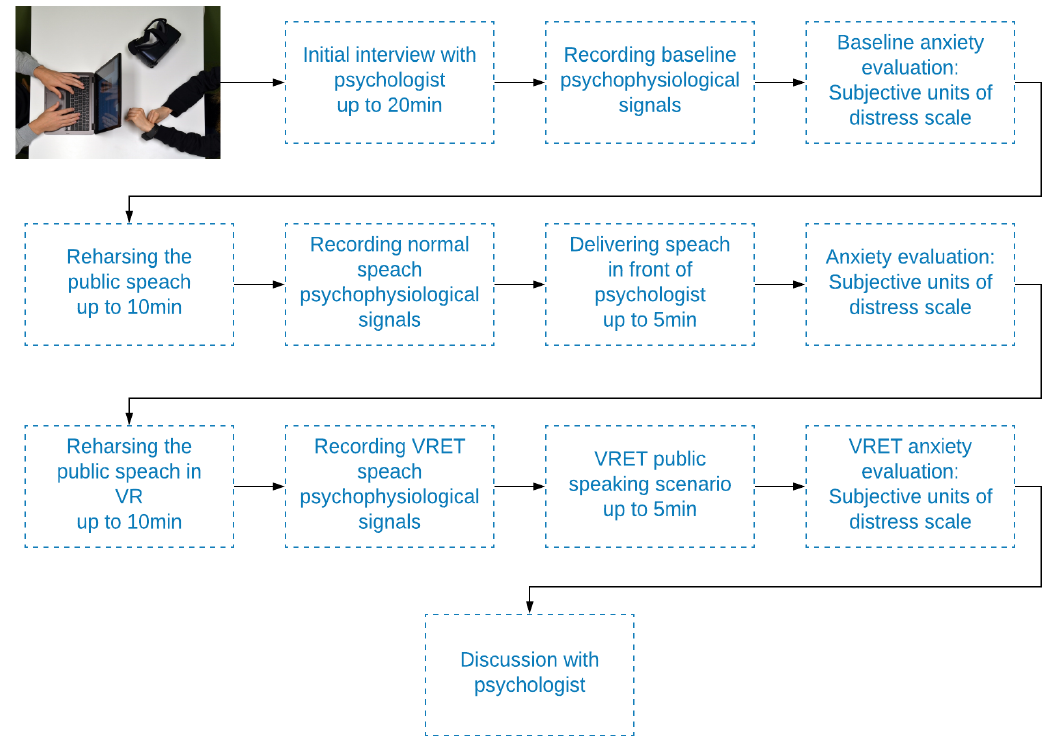
Figure 3. Flow of the VRET public speaking anxiety treatment session during the experiment.